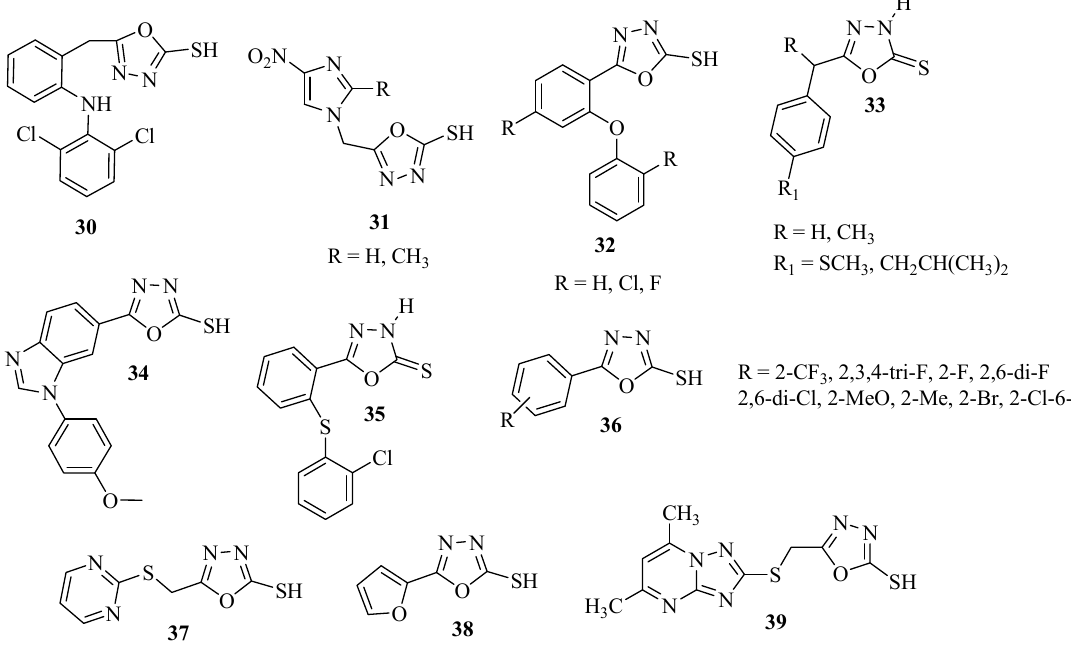
Figure 4. 5-Aryl-1,3,4-oxadiazole-2-thiols obtained by reaction of acylhydrazide with carbon